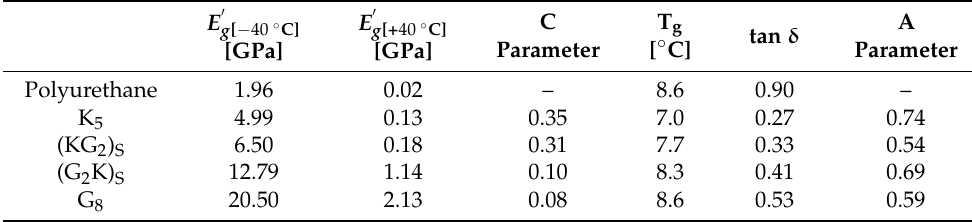
Table 3. Compilation of results from DMA curves shown in Figure